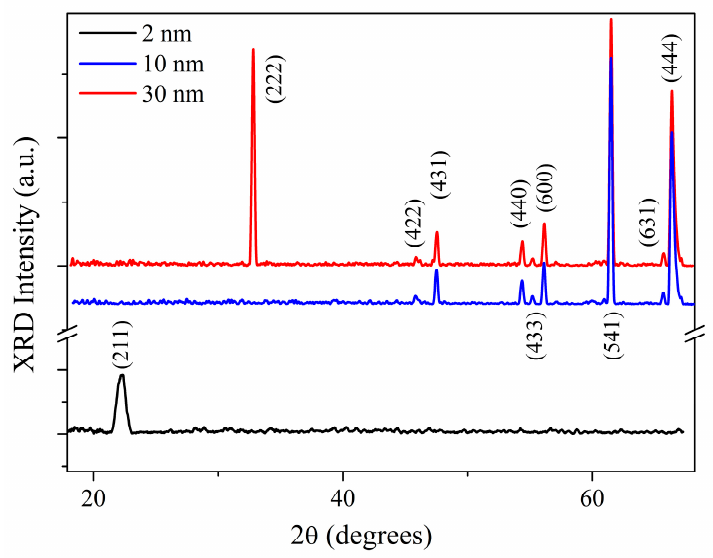
Figure 7. XRD pa tt erns of scandium oxide fi